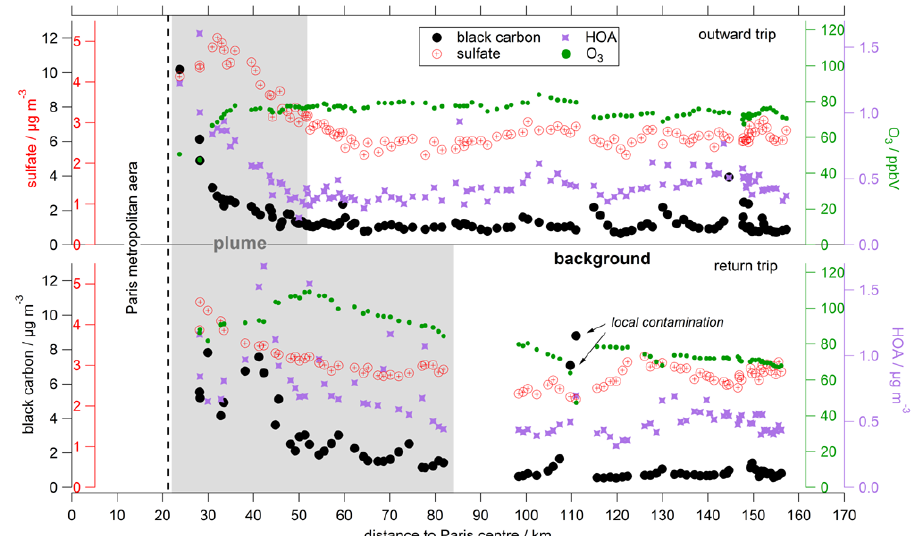
Fig. 5. Black carbon (large black dots), HOA (purple stars) and sulfate (red dots and crosses) mass concentrations and O 3 mixing ratio (small green dots) versus distance to Paris centre measured during an axial trip on 1 July 2009 by the mobile laboratory MoLa. In the upper part of this graph results of the outward trip carried out during the morning are presented, in the lower part results from the return trip during the afternoon. The data points identified as significantly influenced by the Paris emission plume are indicated by the grey area. The time resolution of the data is